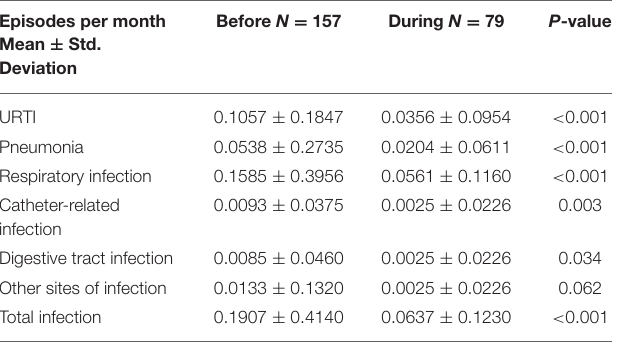
TABLE 3 | Comparison on infectious episodes before and during the COVID-19 pandemic. Episodes per month Mean ± Std.